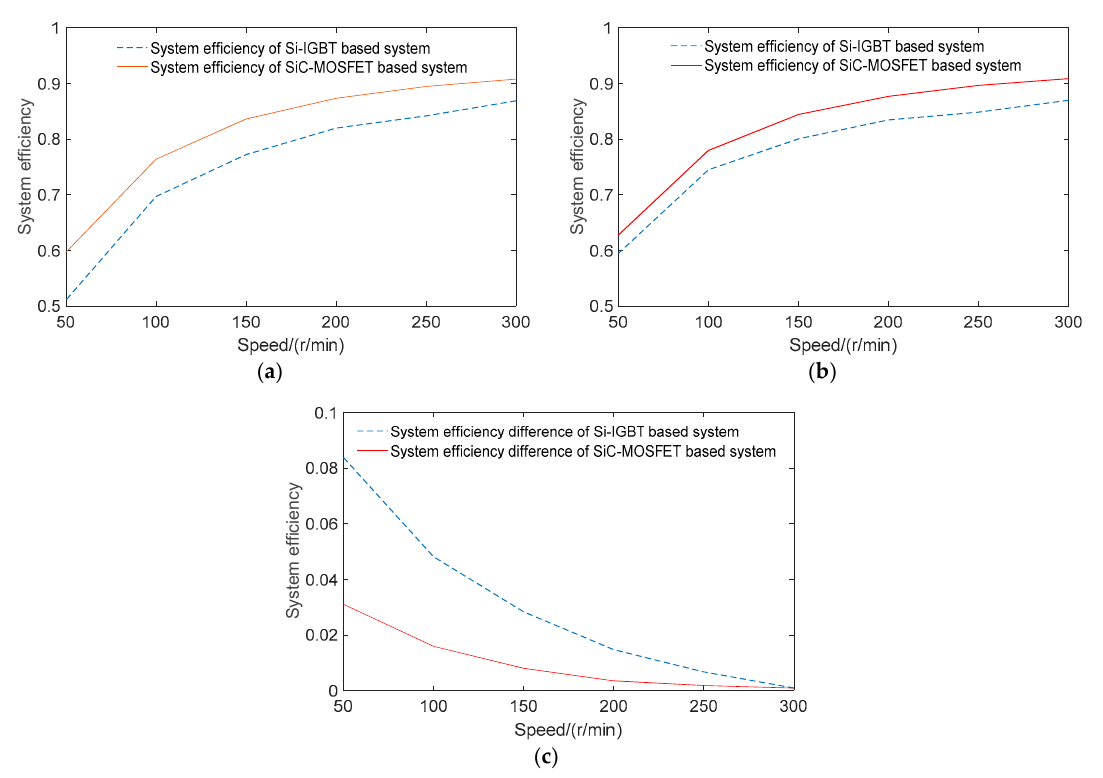
Figure 15. System efficiency of the Si-IGBT-based PMSM drive system and SiC-MOSFET-based PMSM drive system by MTPA control and the proposed control. ( a ) System efficiency of the PMSM drive system by MTPA control; ( b ) System efficiency of the PMSM drive system by the proposed control; ( c ) System efficiency difference between the traditional MTPA control and the proposed control method in the Si-IGBT-based system and SiC-MOSFET-based system.